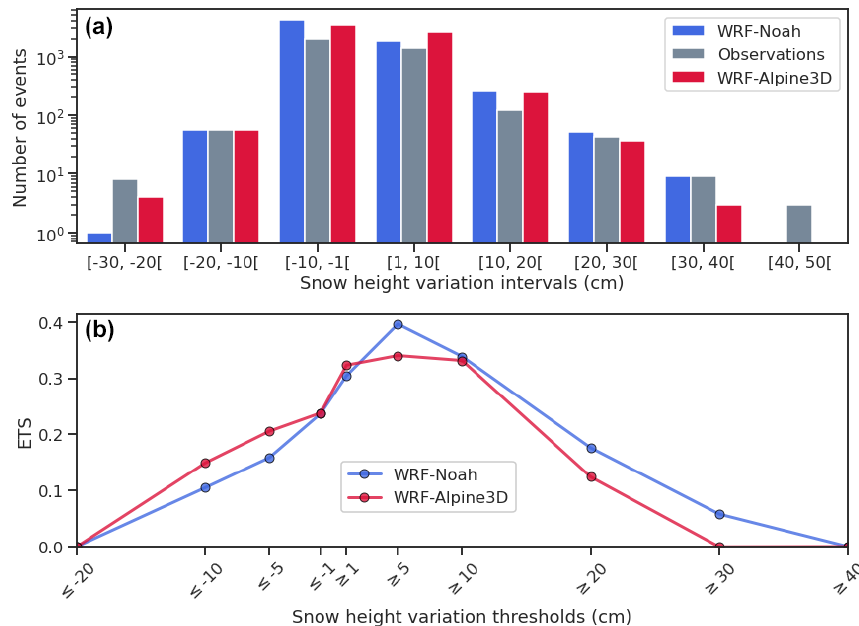
Figure 6. (a) Observed and modeled frequency distribution of daily snow height variation for the three snow seasons obtained from the AWSs used in this study. The gray columns represent the observed variations, and the blue and red columns represent the snow height variations simulated with WRF–Noah and WRF–Alpine3D, respectively. (b) The ETS index for different snow thresholds with blue and red lines indicating WRF–Noah and WRF–Alpine3D scores,